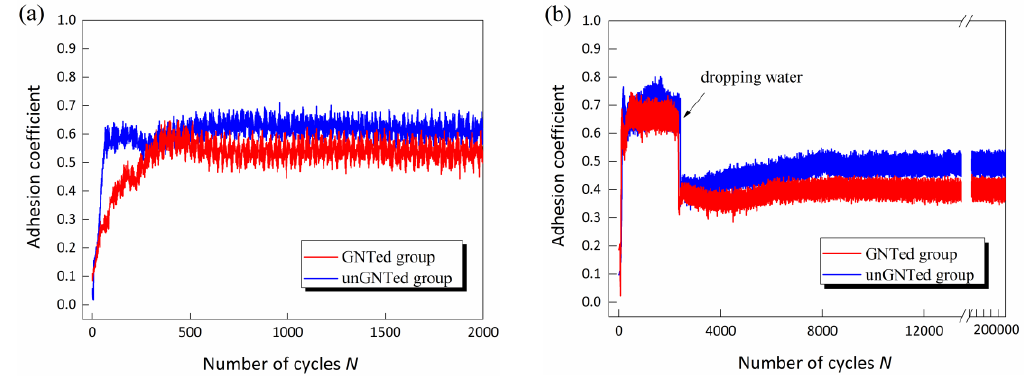
Figure 8. Time-varying curve of adhesion coefficient between the wheel and rail for the wheel with nitriding treatment and without nitriding treatment: ( a ) N = 2 × 10 3 ; ( b ) N = 2 × 10 5 .